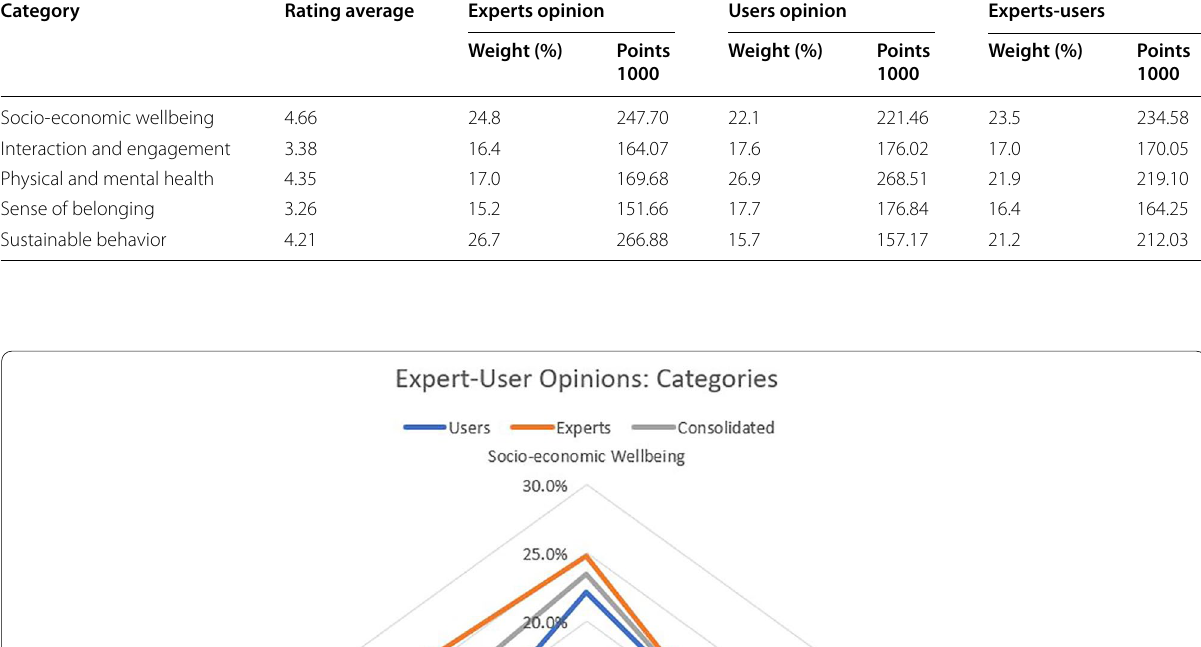
Table 2 Rating and distributed weight of the main framework categories Category